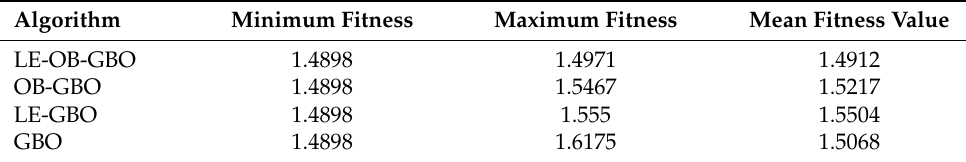
Table 8. Statistical analysis for charging station placement—case 1.